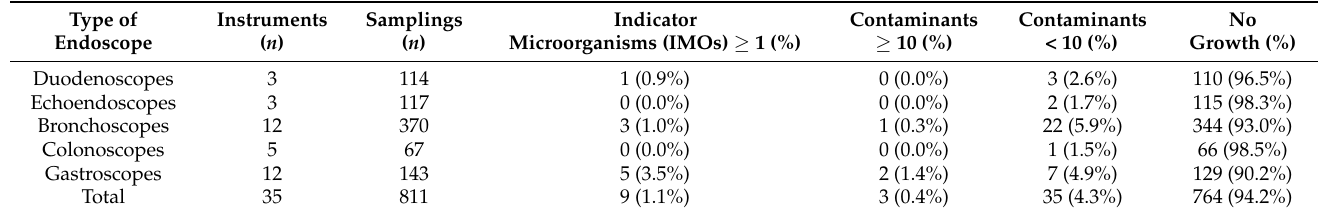
Table 1. Number of total samplings by instrument and number of indicator microorganisms (IMOs) and contaminants, with respective level of contamination in percent, from January 2016 to December 2019.